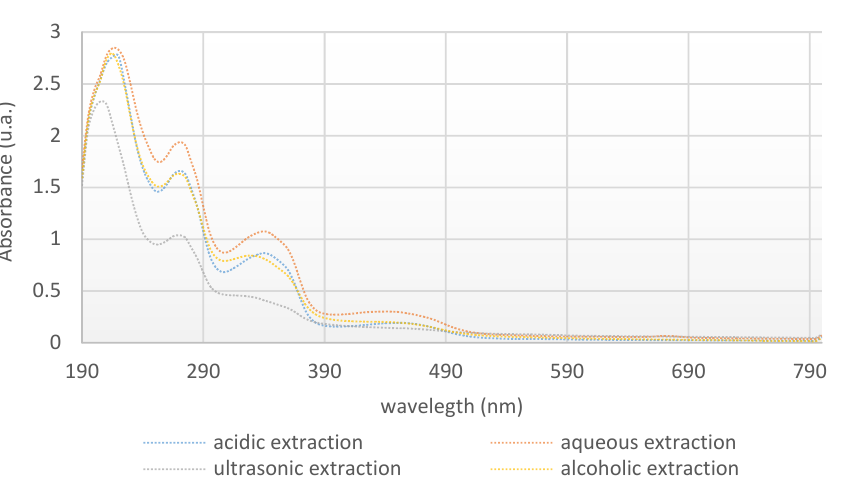
Table 2. pH values of celandine extracts.